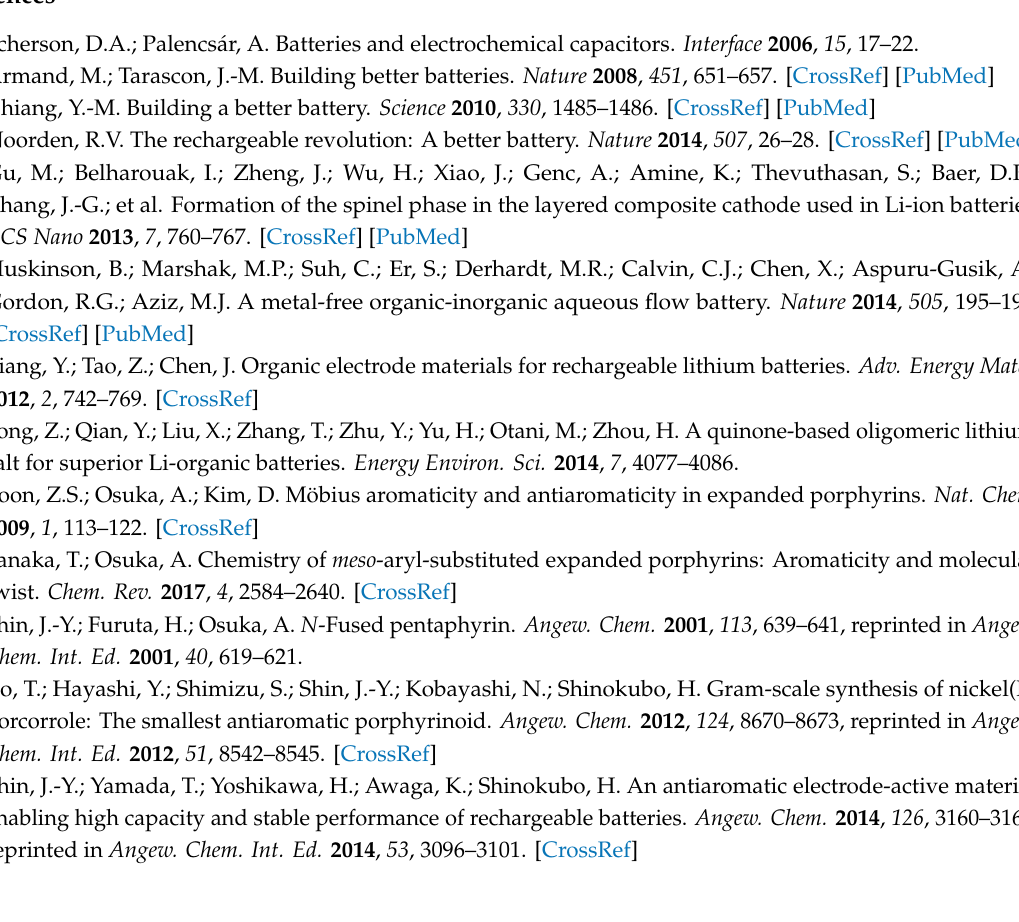
Supplementary Materials: The following are available online. Figure S1: Charge / discharge performances of Li-[28]Hex battery: Earlier (red) and later (blue) cycles (range = 2.0~4.0 V, number of cycles = 20, and operation current = 0.2 mA). Figure S2: Potential energy diagram for the frontier molecular orbitals of Hückel antiaromatic and Möbius aromatic [28]hexaphyrins. Figure S3: Potential energy diagram for the frontier molecular orbitals of Hückel antiaromatic and Möbius aromatic [28]hexaphyrins. Figure S4: Battery performance Li-[28]Hex battery over 1000 cycle. Figure S5: Background CV of pure carbon black for the Figure 3 with the voltage window of 2.0~4.0V and a scan rate of 2.0 mV / s. Figure S6: EIS plot before and after 200 cycles of charge / discharge